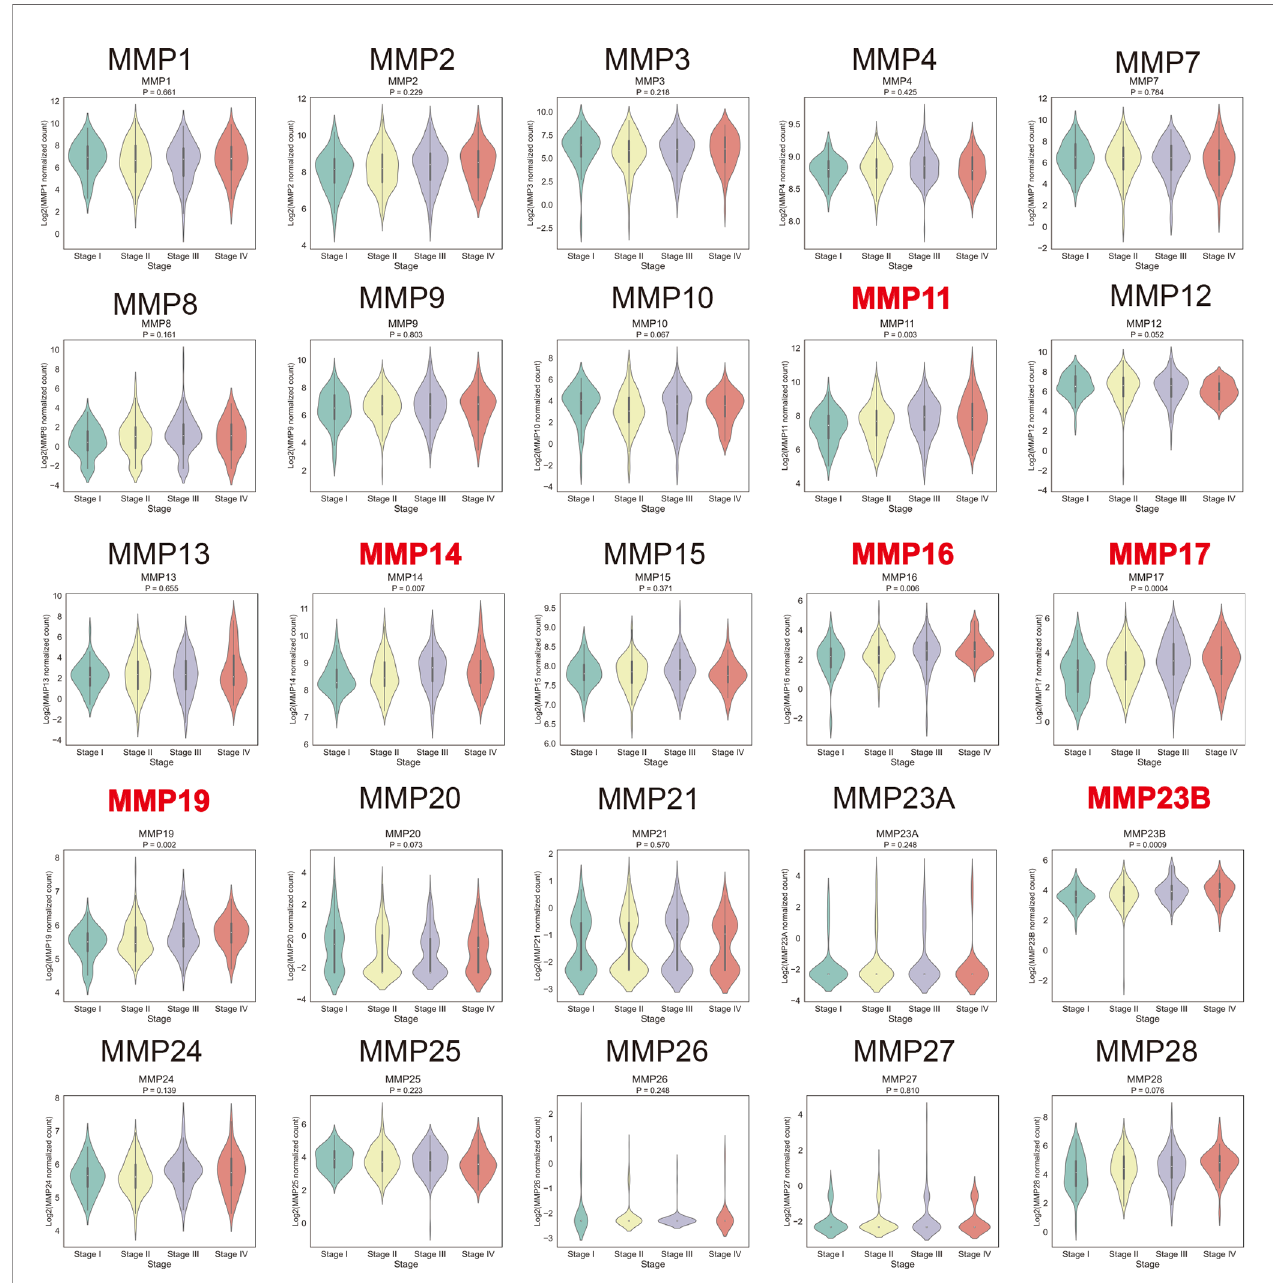
FIGURE 5 | Association of the mRNA levels of MMPs with tumor stage of patients with colorectal cancer. The titles of upregulated records are highlighted in red, while the titles of downregulated records are highlighted in